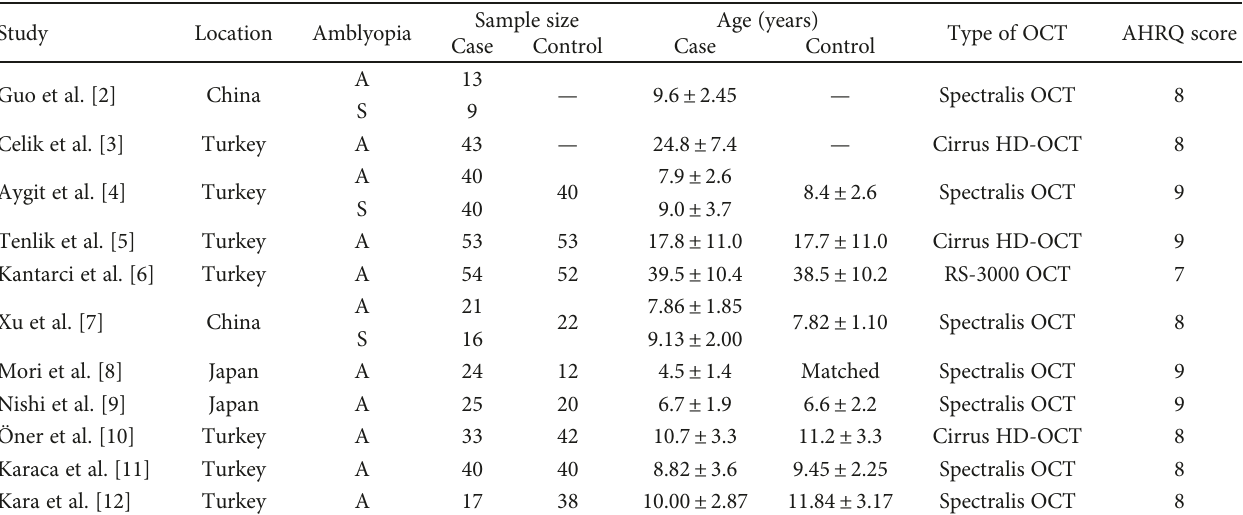
Figure 1: PRISMA fl ow diagram of studies included in the meta-analysis. Table 1: Characteristics of the 11 studies included in the